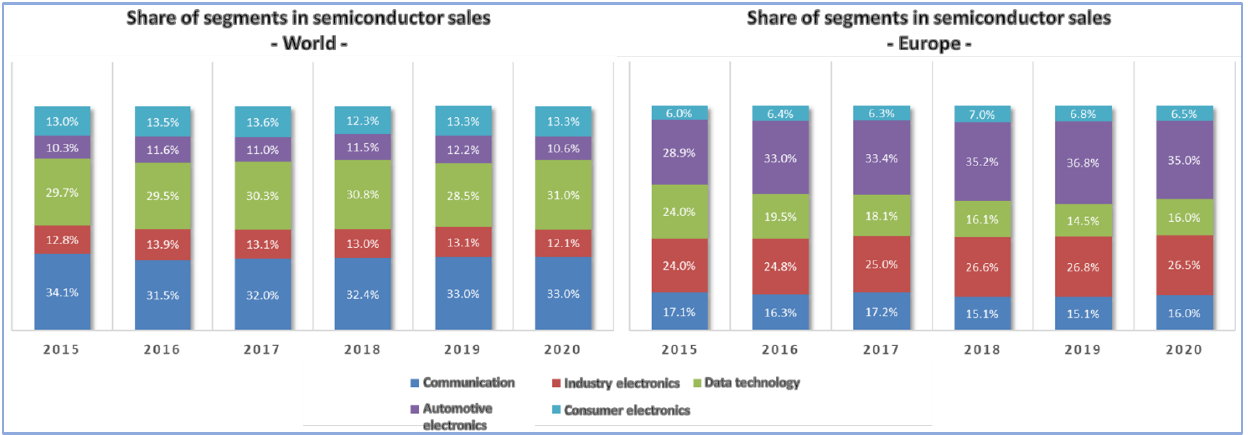
Figure 2. Share of individual segments in semiconductor sales in comparison with the world and Europe, 2015 – 2020 [3,4]. Europe, 2015–2020